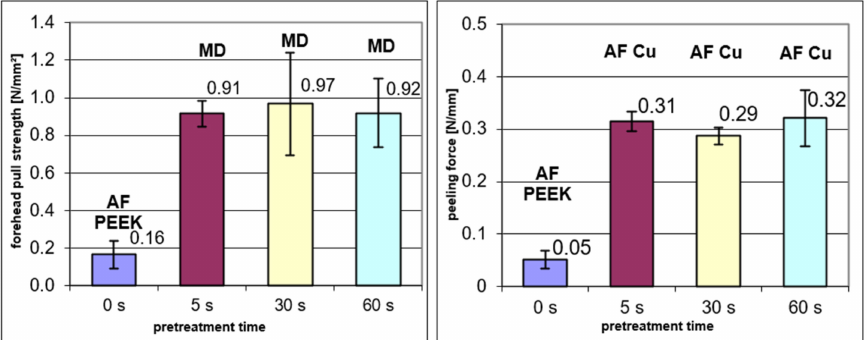
Figure 6. Pull strength ( left ) and peeling force ( right ) of glued copper foils after various pretreatment times of the PEEK films in chromium sulfuric acid. AF PEEK: Adhesion failure between PEEK film and adhesive, AF Cu: Adhesion failure between copper foil and adhesive, MD: Disruption of PEEK film below glued copper